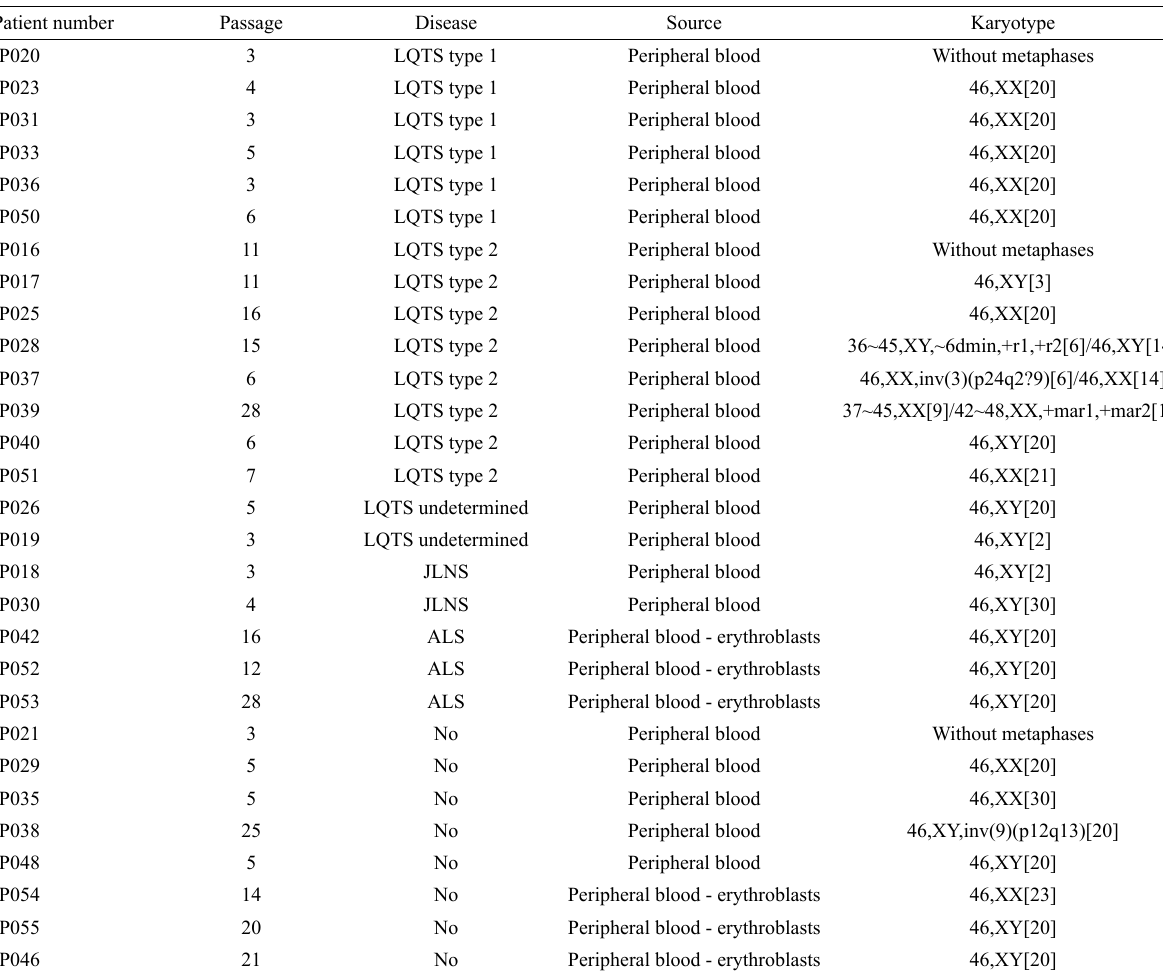
Table 1 ‒ Karyotype analysis in the different